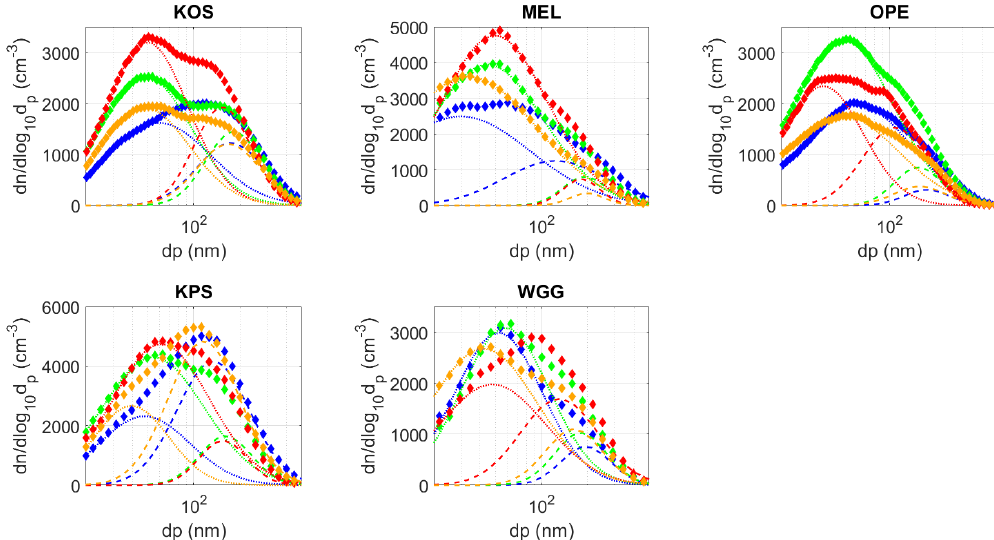
Figure A5. Median particle size distributions (diamonds) and corresponding modes (dotted lines) at rural background continental sites. See Fig. A1 for an explanation of the symbols.